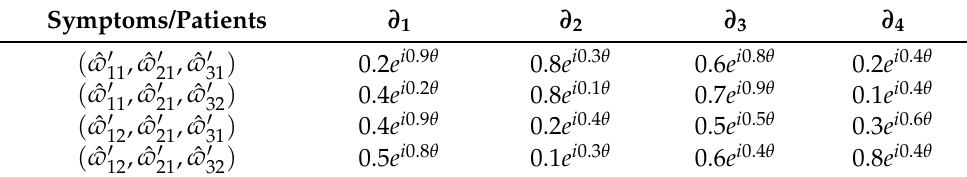
Table 7. z F (cid:48) : Scales assigned to each C FH S patient’s clinical manifestations.